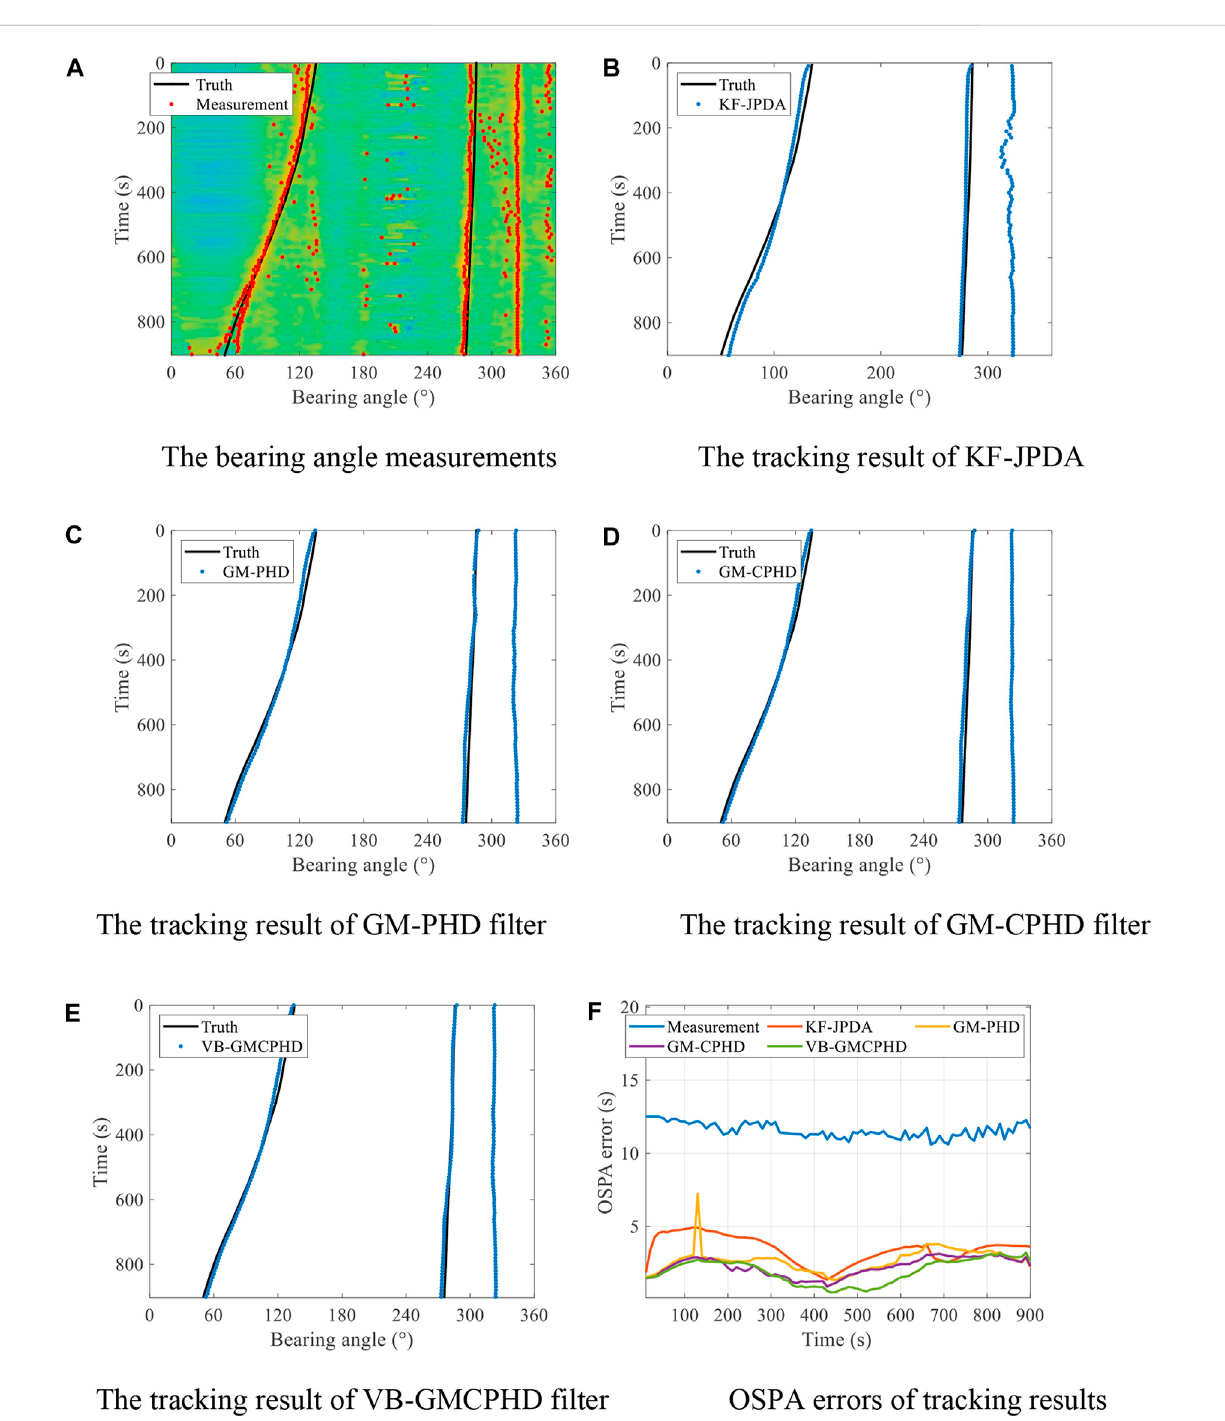
FIGURE 2 Bearinganglemeasurements,trackingresults,andtheOSPAerrorsofKF-JPDA,GM-PHD fi lter,GM-CPHD fi lter,andVB-GMCPHD fi lter. (A)